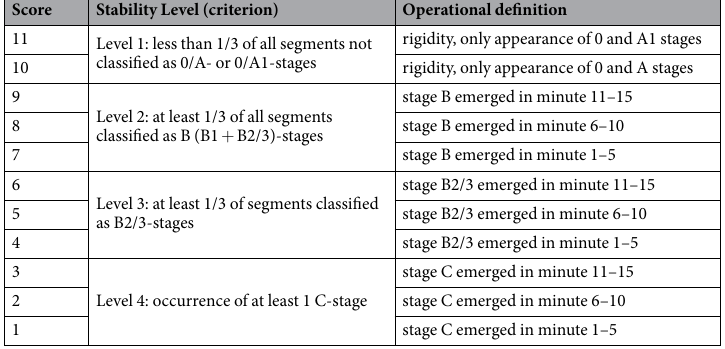
Table 2. Arousal Stability Score corresponding to occurrence of certain vigilance stages during a 15-min resting